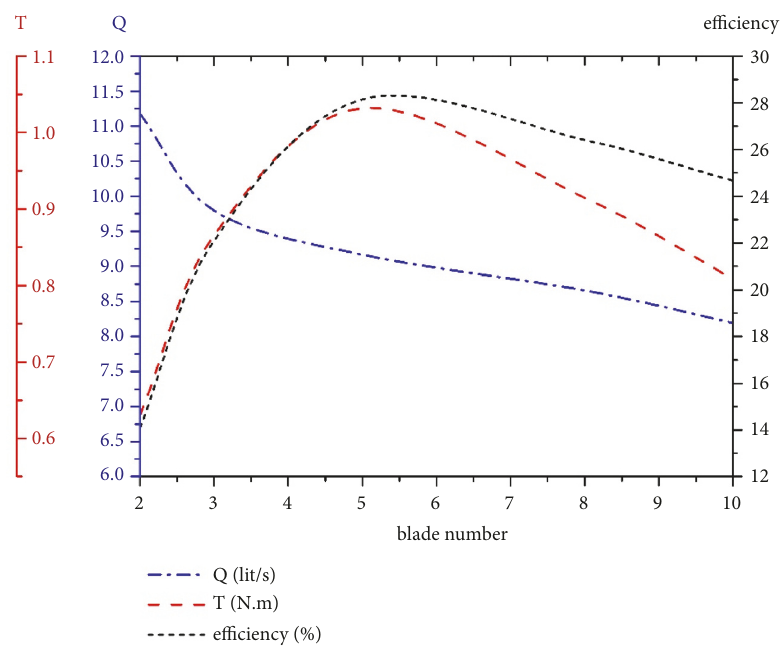
Figure 8: Flow rate, efficiency, and torque change vs. blade